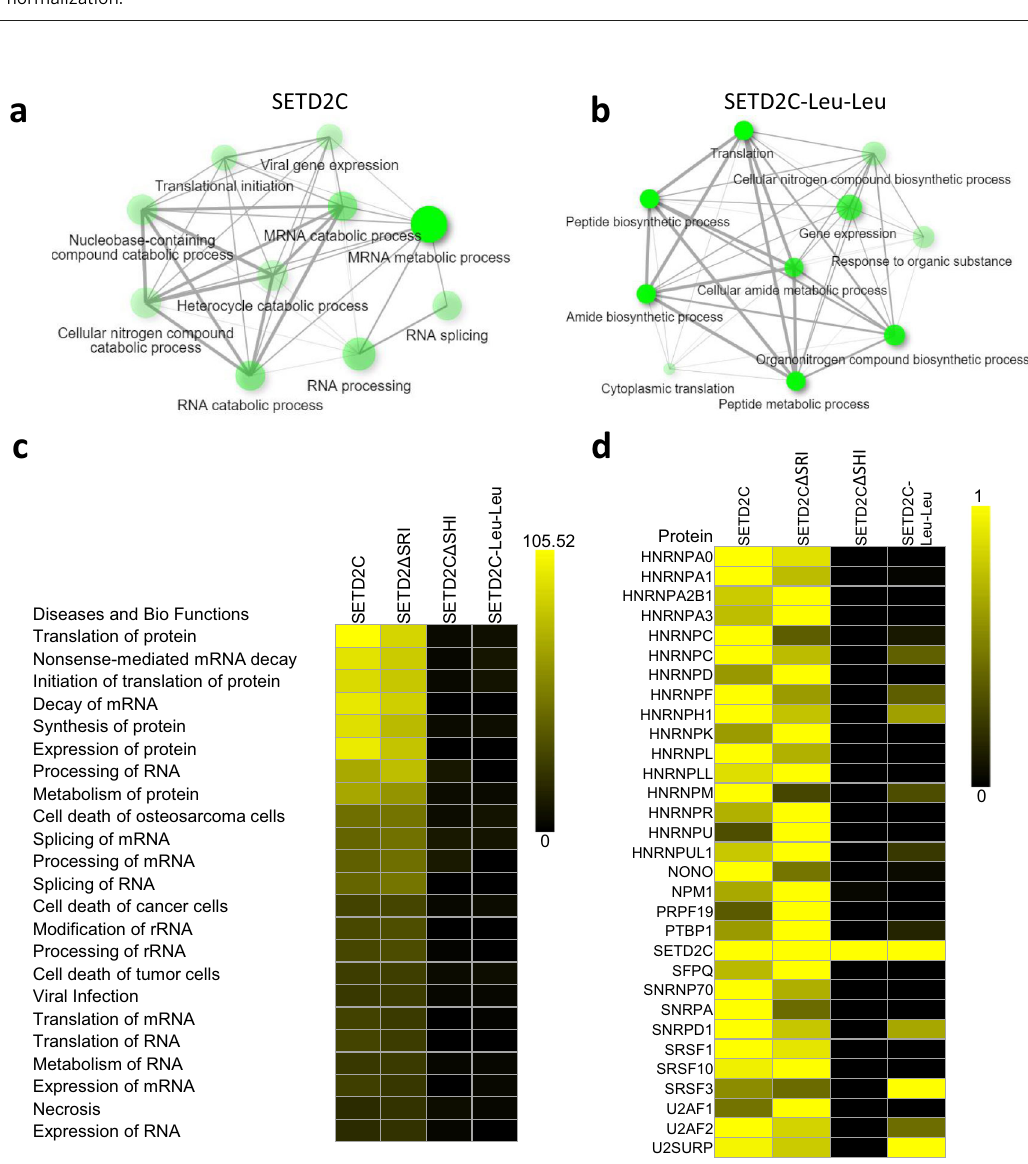
Fig. 6 Transcriptome-wide and gene-speci fi c analysis of the regulatory effect of hnRNP L paralogs. a Chart showing the decrease in expression of the genes depicted based on RNA-seq analysis post siRNA treatment. b , c Venn diagrams showing the overlap of differentially expressed genes and AS events upon hnrnpl and hnrnpll depletion as compared to scramble siRA treated cells. d Pie chart showing the fractions of differentially AS events that occur in both hnrnpl and hnrnpll depletion. e , f Genome browser view showing retention of introns in tjp1 and bptf genes upon hnrnpl depletion. g – j RNA was isolated from 293 T cells 72 h post-transfection with scramble siRNA, or siRNA against hnrnpl or hnrnpll . Also, k – n RNA was isolated from sihnRNPL expressing 293 T cells rescued with vector control (VC), hnRNP L, or hnRNP LL constructs. Speci fi c primers were designed to detect the indicated genes and exons and individual alternative splicing events were checked by RT-PCR ( h , l ) (source data are provided as a Source Data fi le, the experiment was repeated two times all yielding similar results), measured by quantitative PCR, and represented by the ratios of depicted exons ( i , j , m , n ). For each sample n = 3 independent biological samples were examined in the same sequencing run. Data are presented as mean values with a standard error of the mean. An unpaired t test (two-tailed) was performed. p -Value < 0.05 was considered signi fi cant. p -Values are depicted on the top of the respective graphs. GAPDH was used for normalization.